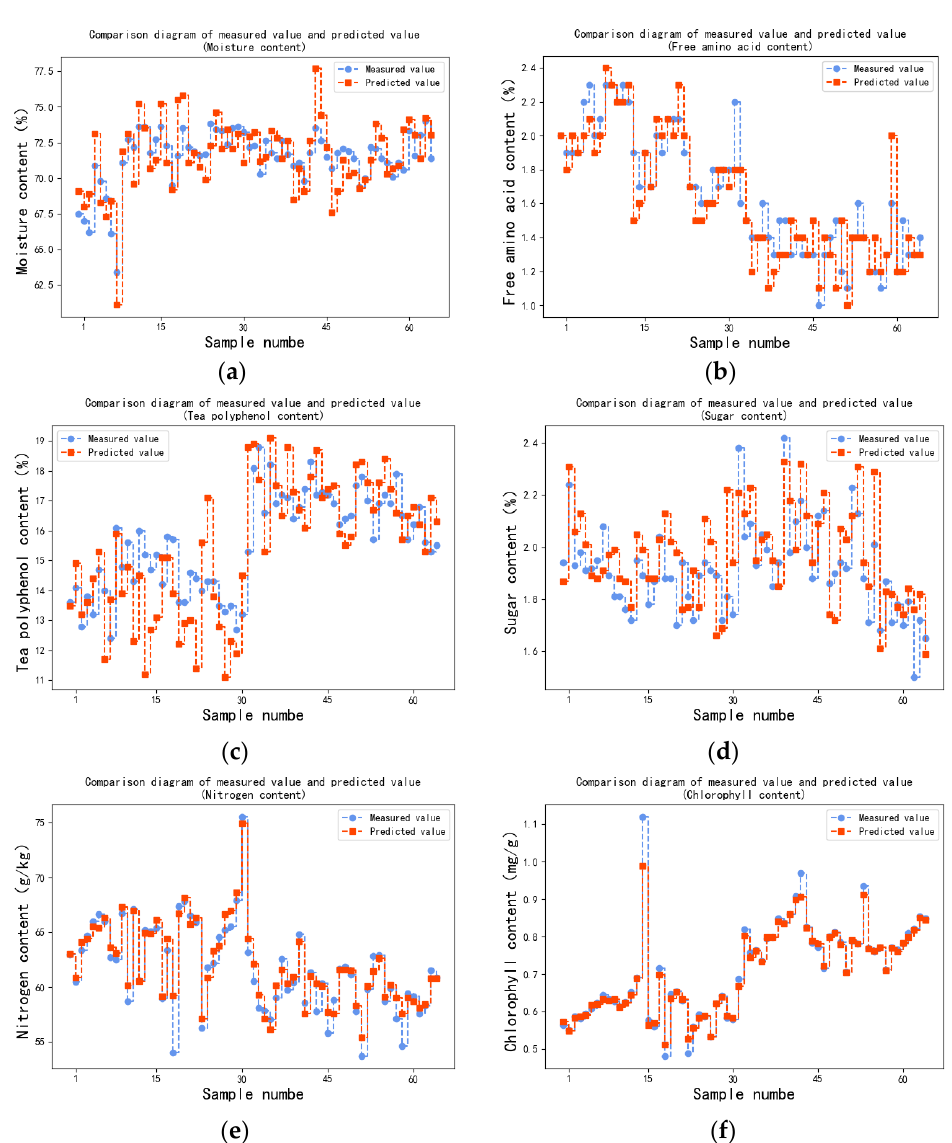
Figure 8. Comparison diagram of the measured and predicted values: ( a ) moisture content; ( b ) free amino acid content; ( c ) tea polyphenol content; ( d ) sugar content; ( e ) nitrogen content; ( f ) chloro- phyll content.